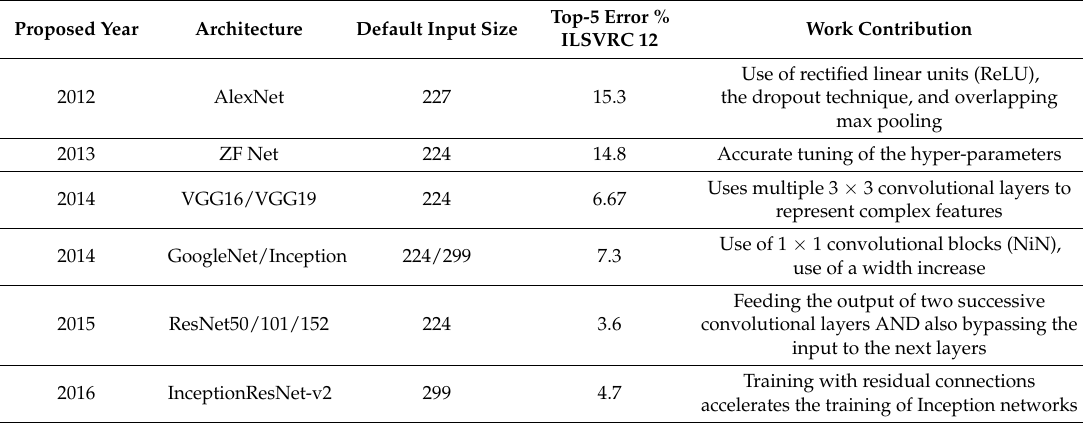
Table 6. The deep neural networks.